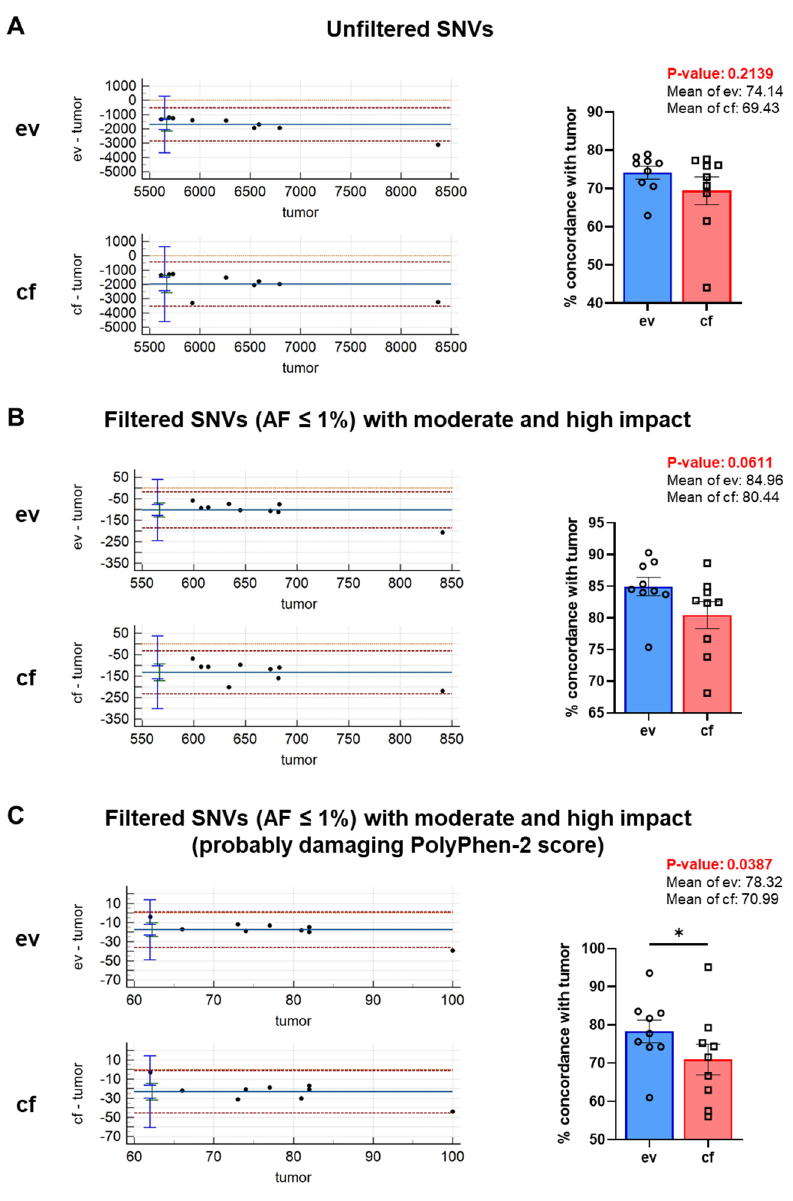
Figure 7. Stringent filtering of variants was applied to increase specificity for tumor-associated variants. Bland–Altman plots and concordance (%) of variants between tumor- and evDNA as well as between tumor- and cfDNA for ( A ) unfiltered SNVs, ( B ) filtered SNVs (AF ≤ 1%) with moderate and high impact and ( C ) filtered SNVs (AF ≤ 1%) with moderate and high impact and a probably damaging PP-2 score. Statistical tests: ( A – C ) Two-tailed paired Student t -test; * p <